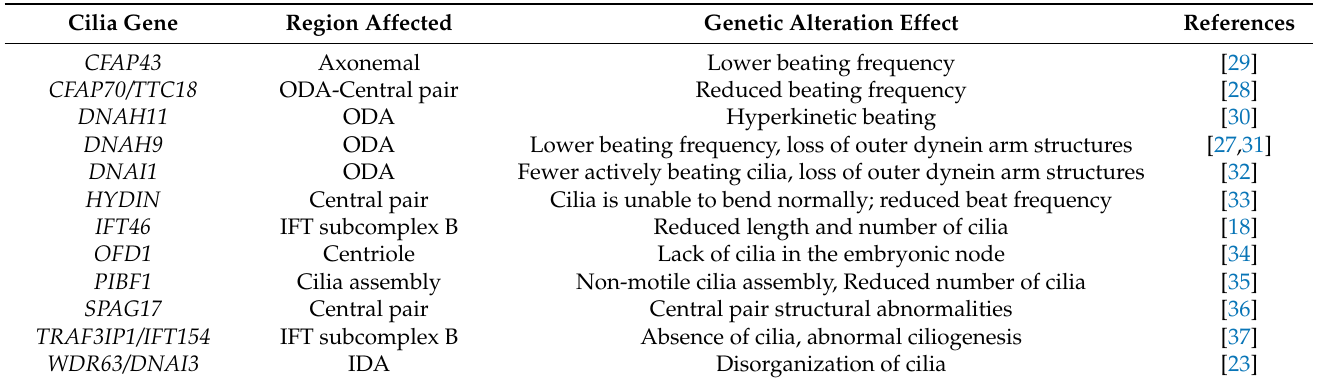
Table 5. Global effect of genetic anomalies in cilia. Deletion of cilia genes influences the process of cilia function and ciliogenesis. ODA: Outer dynein arm, IDA: Inner dynein arm. Cilia Gene Region Affected Genetic Alteration